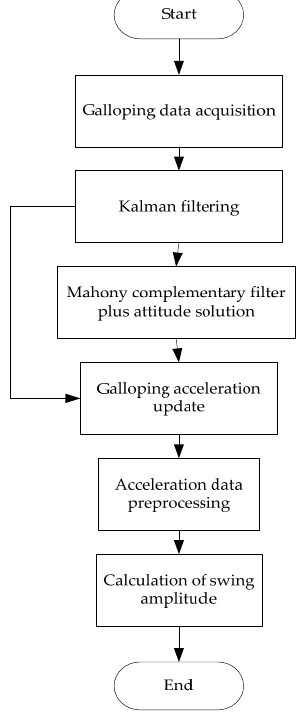
Figure 8. Algorithm Design Flowchart.